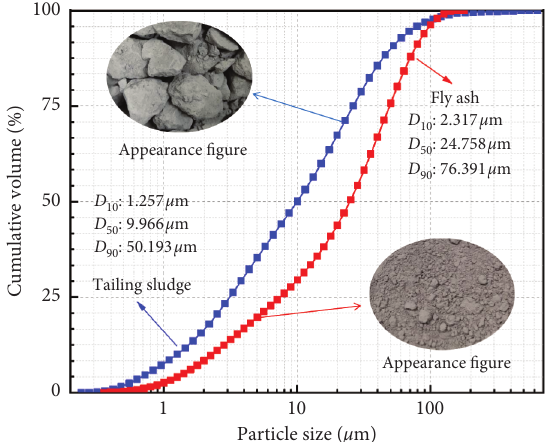
Figure 2: Particle size distribution of tailing sludge and fly